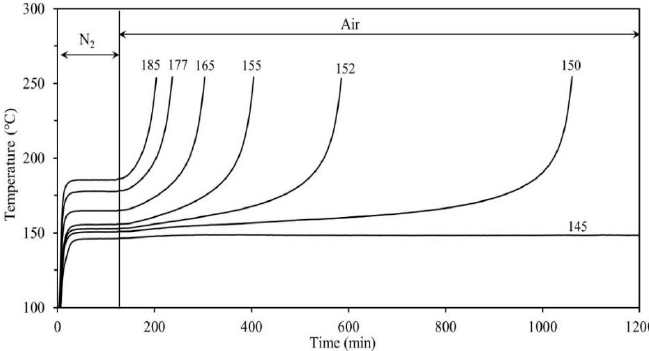
Figure 15. SIT curves for fishmeal over the 100 °C to 200 °C range.